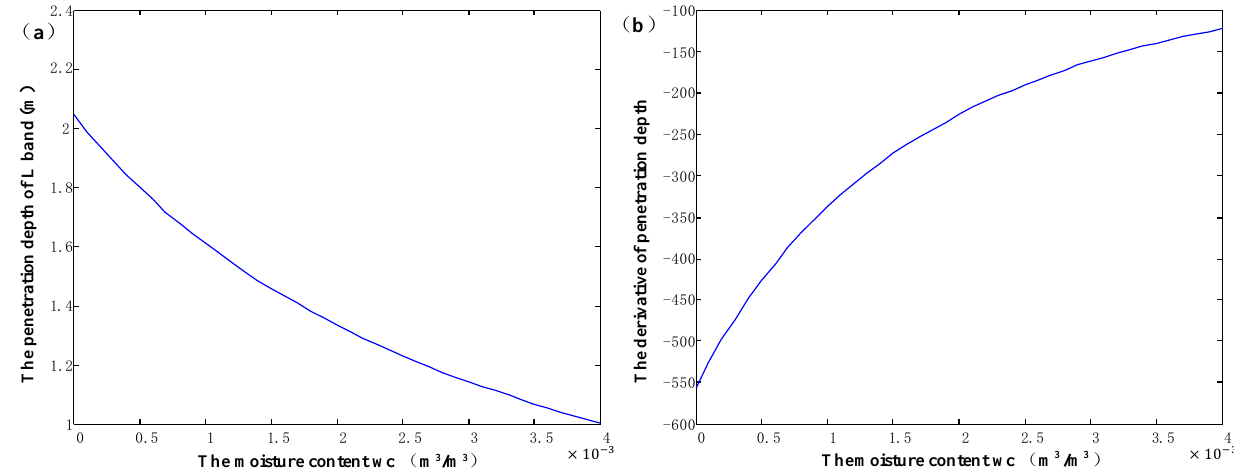
Figure 12. ( a ) The penetration depth of L band. ( b ) The derivative with respect to wc . As stated in Section 3.2, the inverted soil moisture content of the study area ranges between 0.01% and 0.36%, the derivative of penetration depth ranges from − 526.6 to − 135.6, as shown in Figure 12b. It is assumed that the soil moisture content inversion by the method proposed in this paper has an absolute error of 0.05%, the estimation error of penetration depth ∆ h (cid:48) ranges from 0.07 m to 0.26 m. errPen By assuming a minimum penetration for the L band in desert area equals 1.035 m ( ∆ h − ∆ h (cid:48) ) , the Baseline length of B equals 4 km and baselines corresponding to a errPen errPen height of ambiguity of H amb = 38 m–51 m (i.e., B ⊥ = 3.76 km for θ i = 20 ◦ and B ⊥ = 2.78